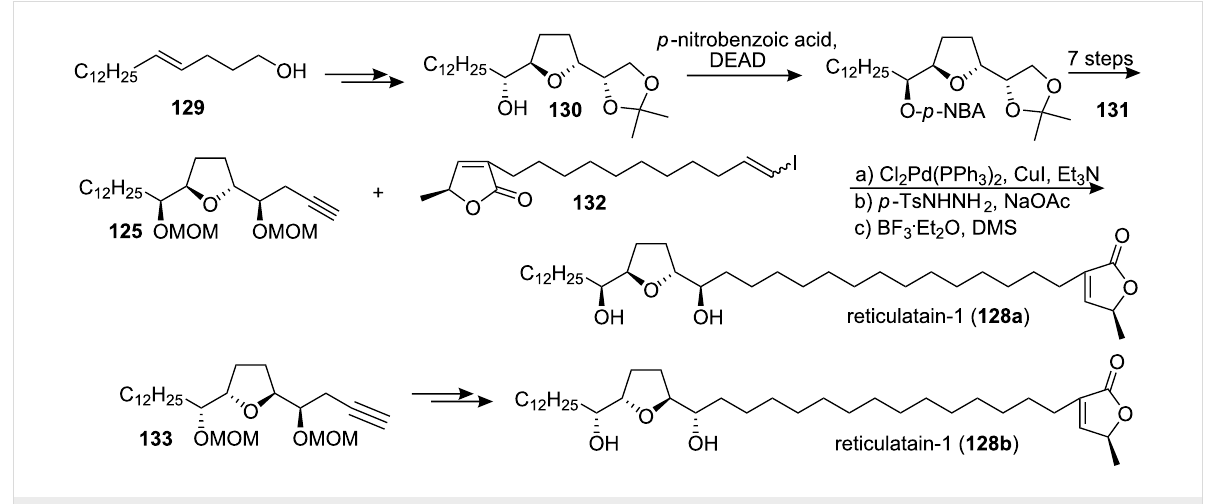
Scheme 19: Total synthesis of reticulatain-1 by Makabe’s